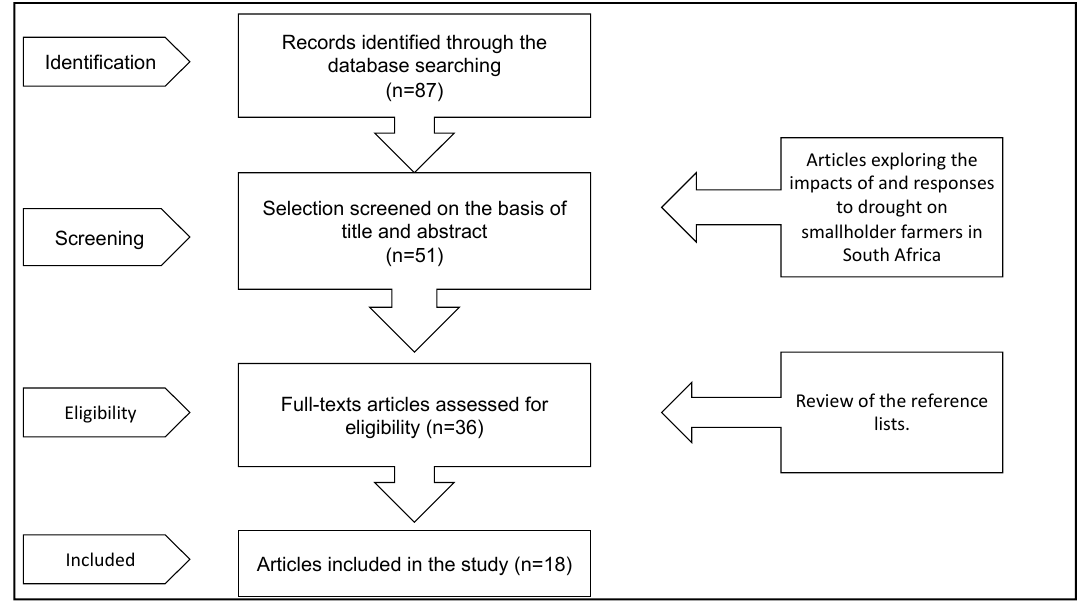
Figure 1. Steps taken in selecting literature.